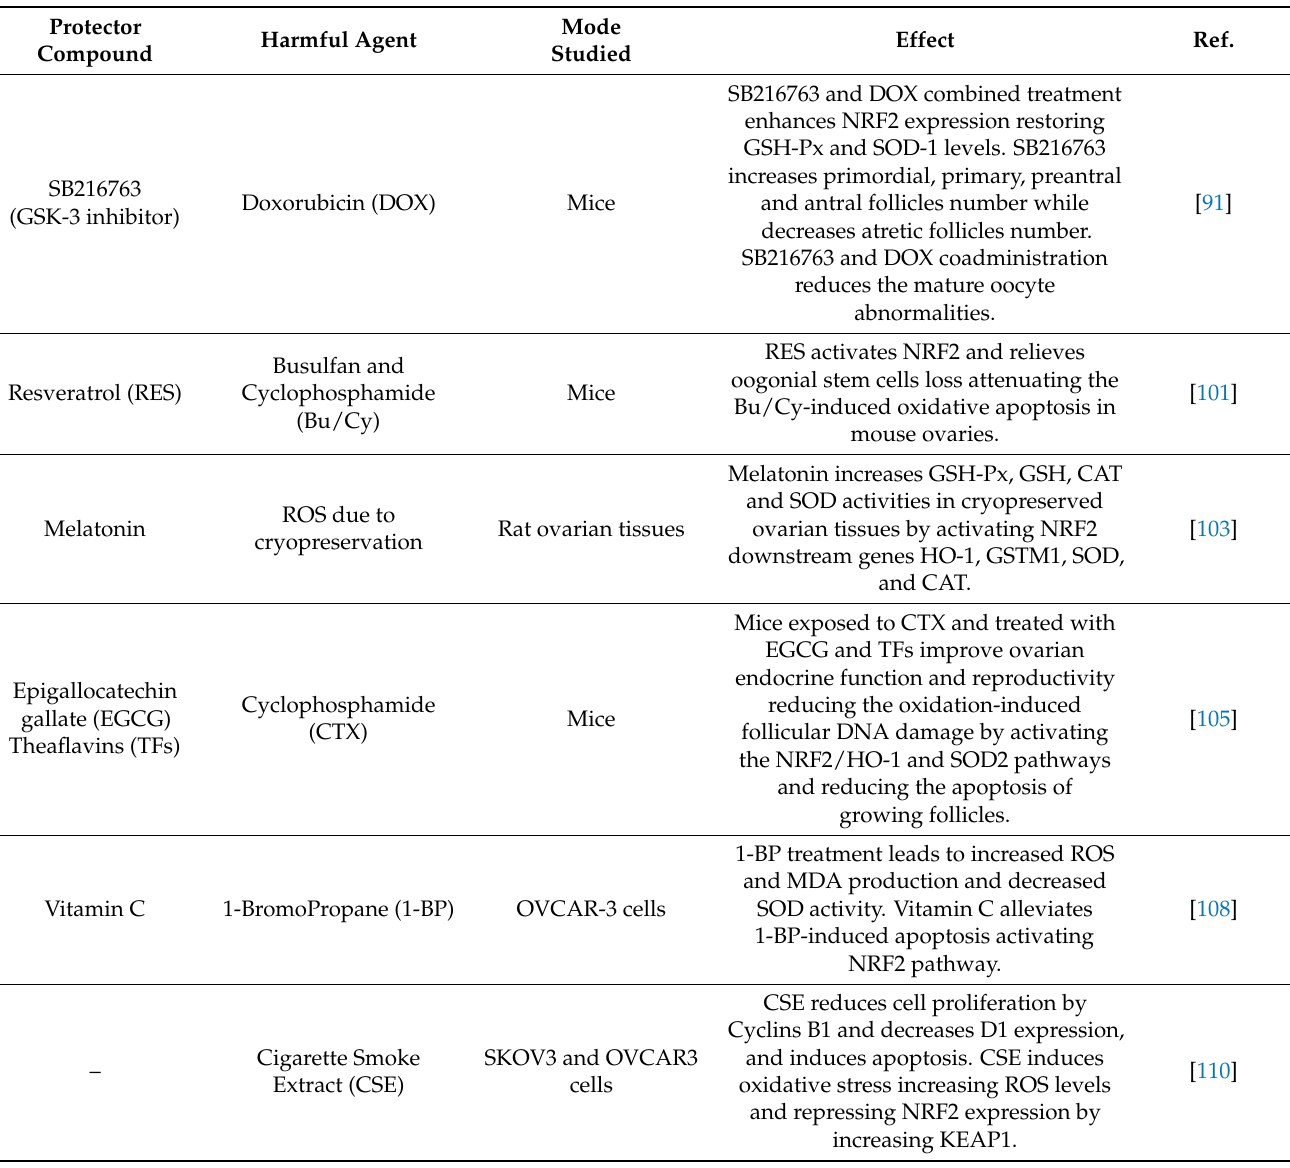
Table 4. Modulators of NRF2 in ovarian